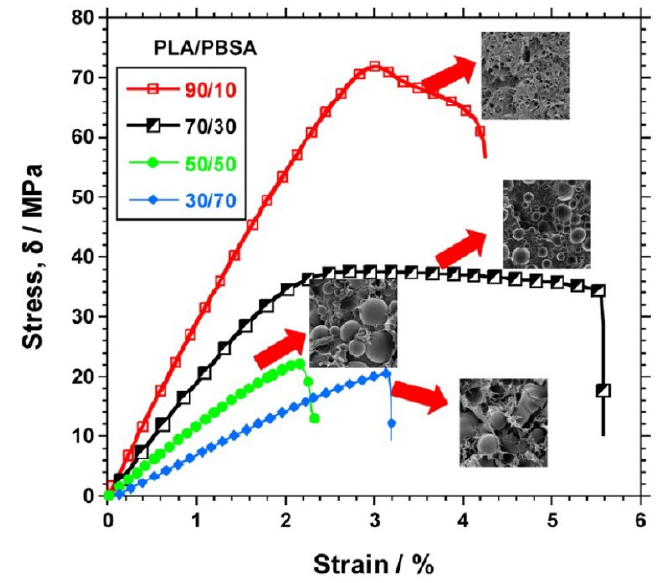
Figure 3. Stress strain curves and SEM micrographs of selected PLA/PBSA blends at different composition. Reprinted with permission from Ref. [84] Copyright 2012 American Chemical Society.